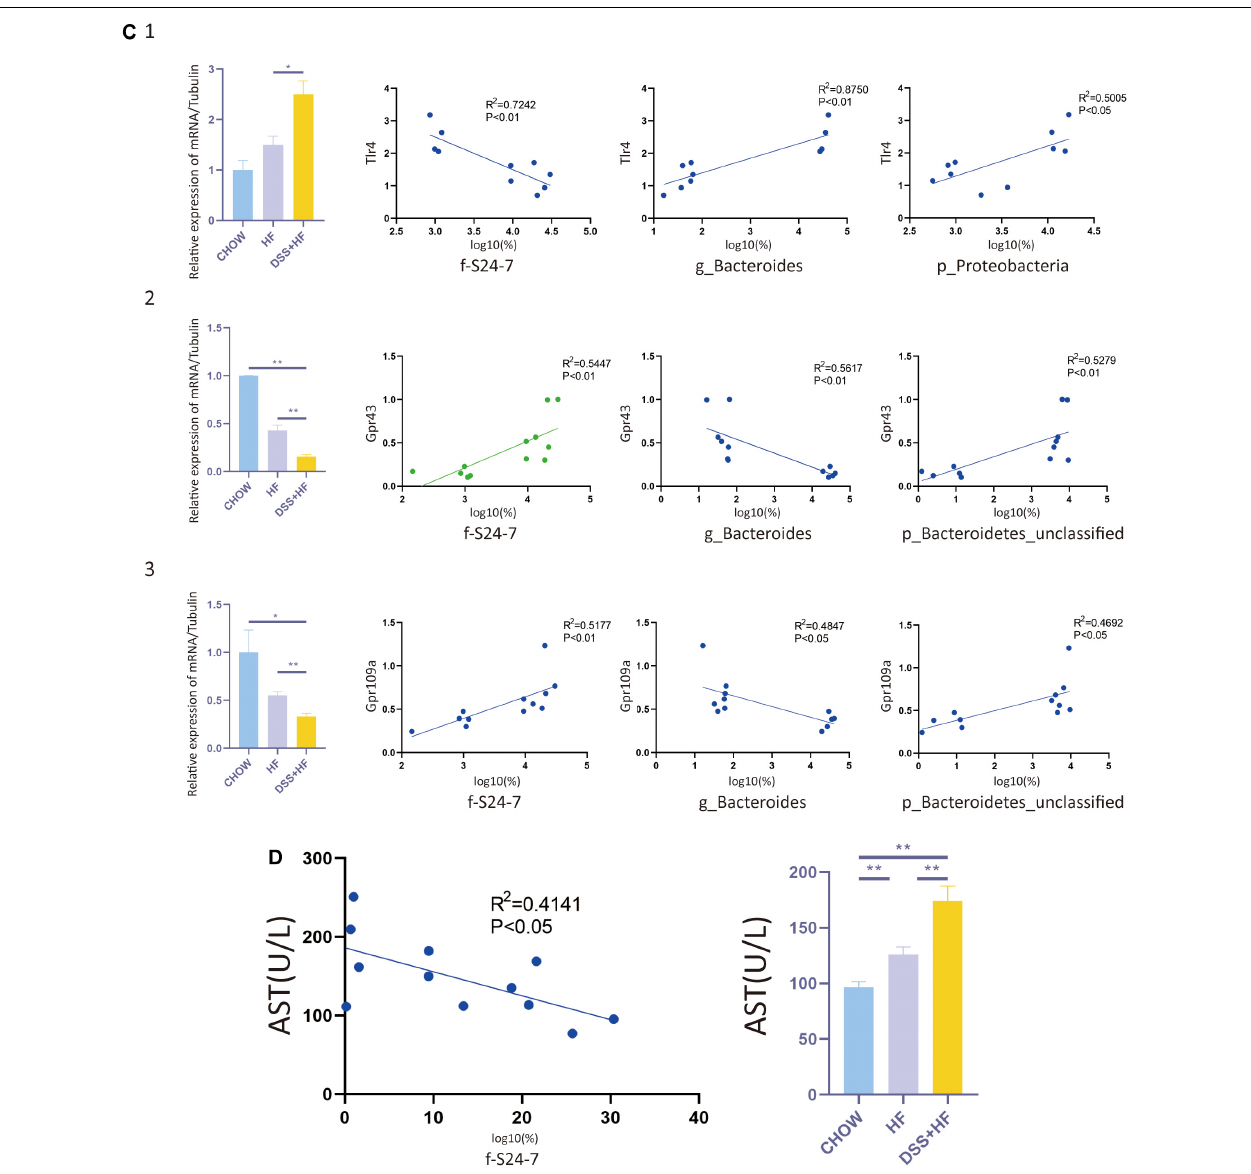
FIGURE 5 | Correlation between gut microbiota and non-parenchymal cells (NPCs) gene expression. (A-1) Correlation between p_Proteobacteria and vascular development related genes (Dll4, Eng, and Gpr4). (A-2) Correla-tion between p_Proteobacteria and inflammation related genes (Ccl4, Cd14, S100a9, and Ccl6). (A-3) Correlation between g_Bacteroides and vascular development related genes (Dll4, Kdr, and Gpr4). (A-4) Correlation between g_Bacteroides and inflammation related genes (Ccl4, Ccl6, and Tlr13). (A-5) Correlation between f_S24-7 and vascular development related genes (Dll4, Kdr and Gpr4). (A-6) Correlation between f_S24-7 and inflammation related genes (Ccl4, Il12b, Tlr8, and Tlr13). X axis represents the percentage of gut bacterium in a logarithmic scale of base 10. Y axis represents the gene expression of NPCs in a logarithmic scale of base 10. (B) Cd31 and Dll4 expression at the RNA level in NPCs from the above groups. The statistical analyses were done with an unparied t -test. ** P < 0.01. (C-1) Correlation between f_S24-7 , g_Bacteroides and p_Proteobacteria and Tlr4. (C-2) Correlation between f_S24-7, g_Bacteroides and p_Bacteroidetes and Gpr43. (C-3) Correlation between f_S24-7, g_Bacteroides and p_Bacteroidetes and Gpr109a. X axis represents the percentage of gut bacterium in a logarithmic scale of base 10. (D) Correlation between f_S24-7 and aspartate aminotransferase (AST). NS, not statistically significant; * P < 0.05; ** P <